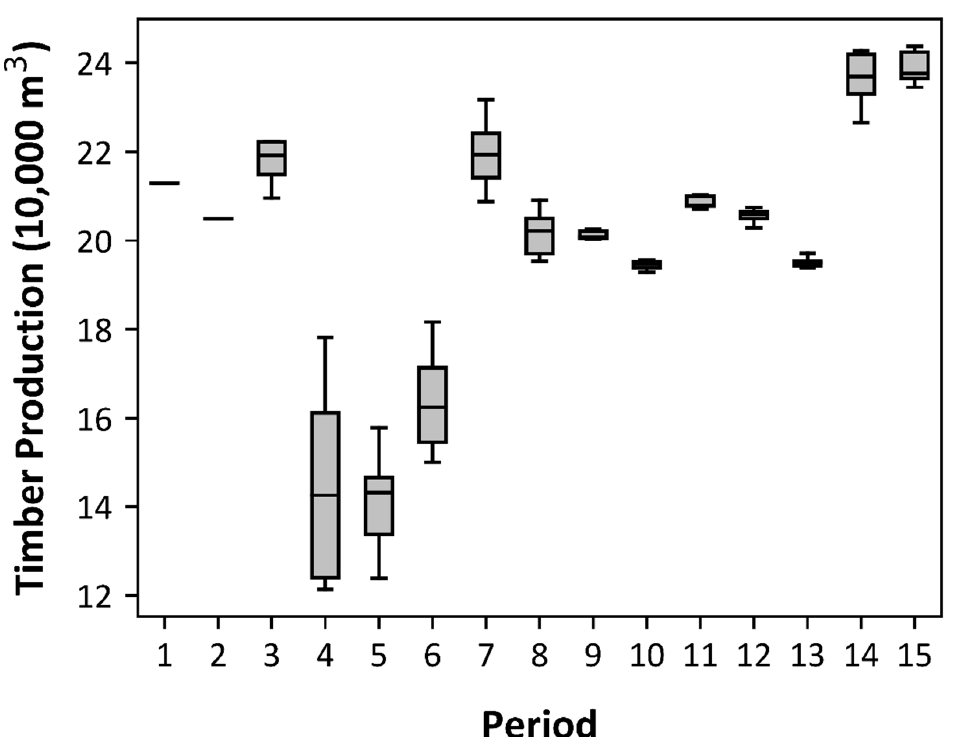
Figure 5. Distribution of timber production volume by alternatives in each period (a period of 10 years). The data in each boxplot include 9 points, representing the volume of timber produced in the period for each alternative.